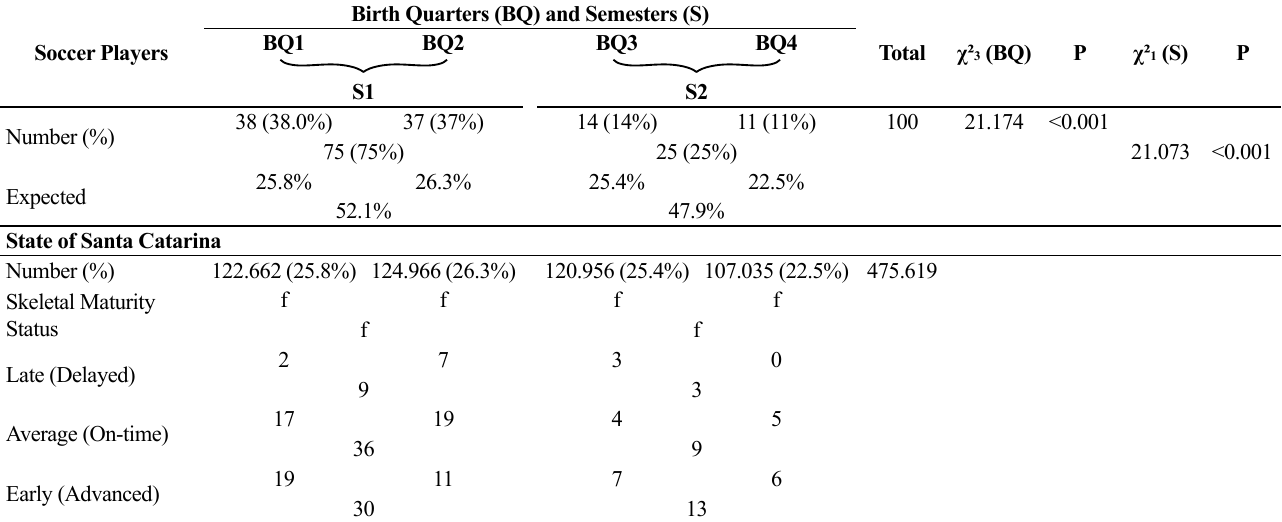
Table 1. Birth date distribution per quarter (BQ) and semester (S) for youth soccer players of the current sample compared to the number of live births in the State of Santa Catarina between 1997 and 2001, and frequency distribution (f) of skeletal maturity status by birth quarter and semester.